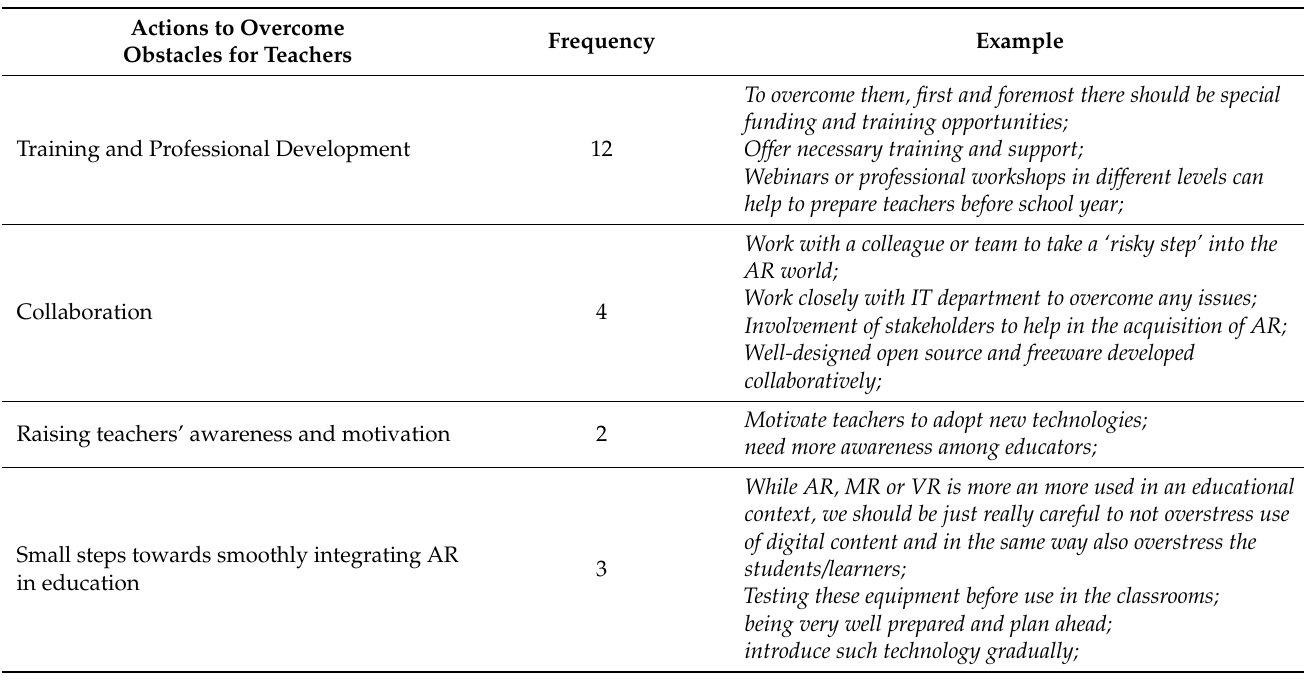
Table 17. Recommendations for teachers.